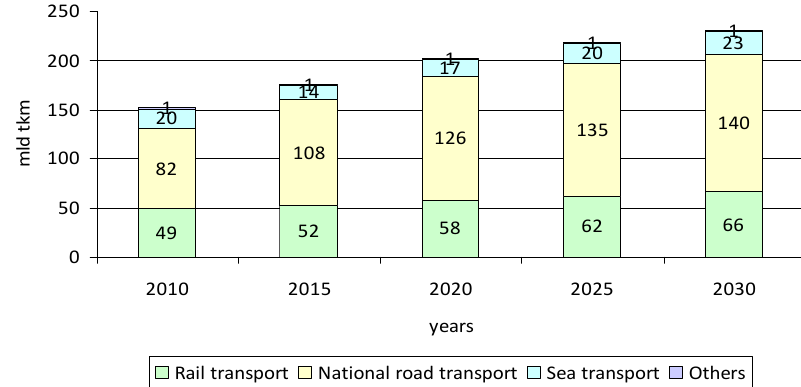
Fig. 4: Freight transport in the reference scenario by 2030. (Dorosiewicz, et al .,